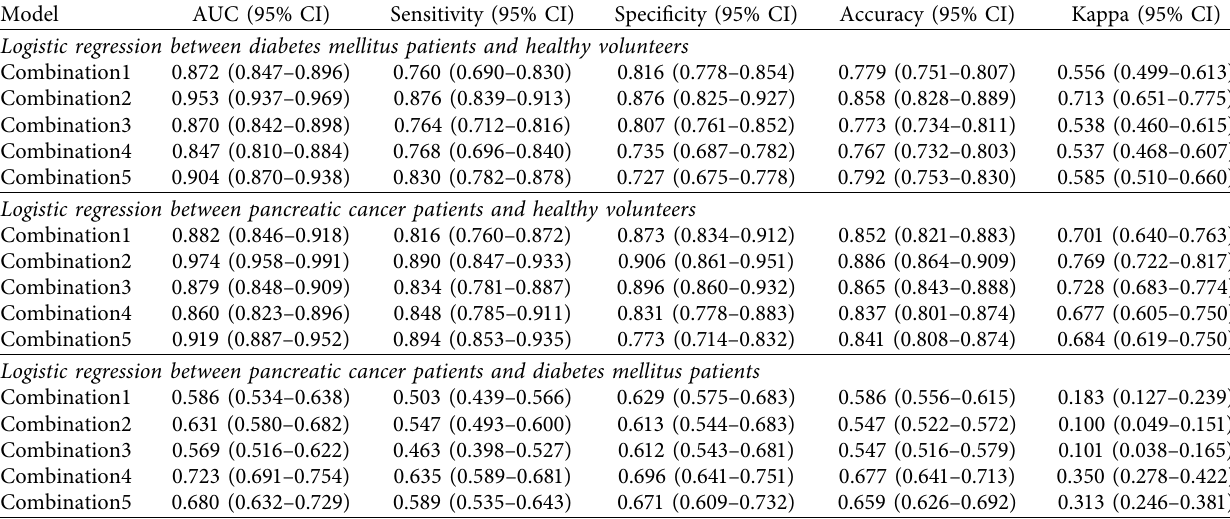
Table 4: Test performance characteristics for the biomarker signature from 5 repeated 5-fold cross-validation.